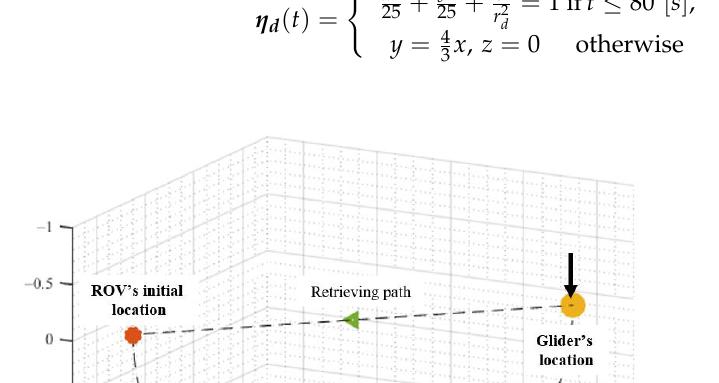
Table 1. The hydrodynamic parameters.